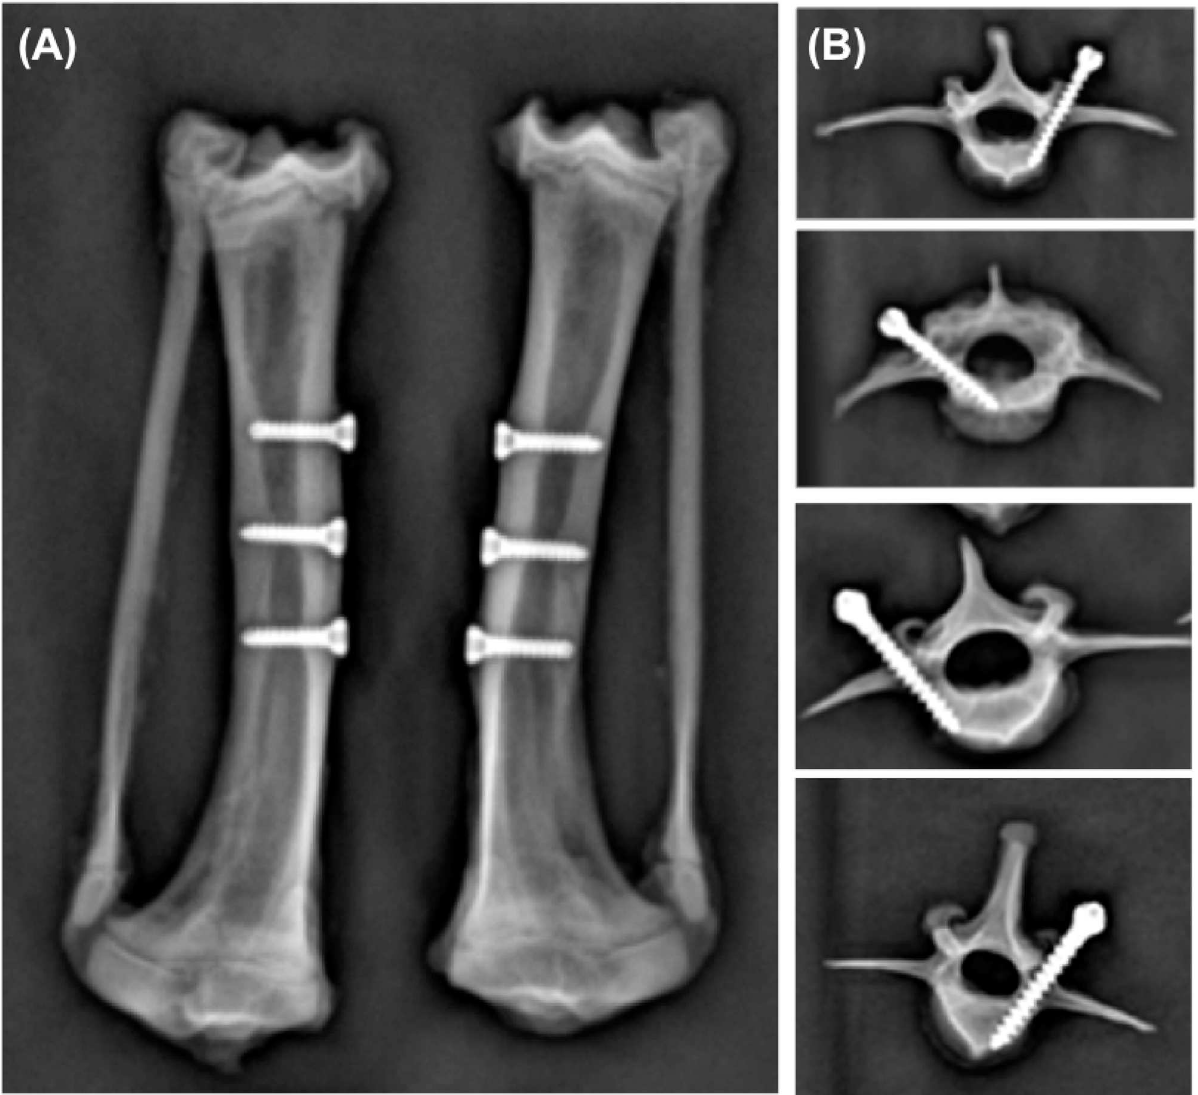
Fig 3. Representative radiographs showing cortex and pedicle screws after implantation. (A) Cortex screw with cortical bone placementand (B) Pediclescrew with traditionalplacementon L2-L5 vertebrae.